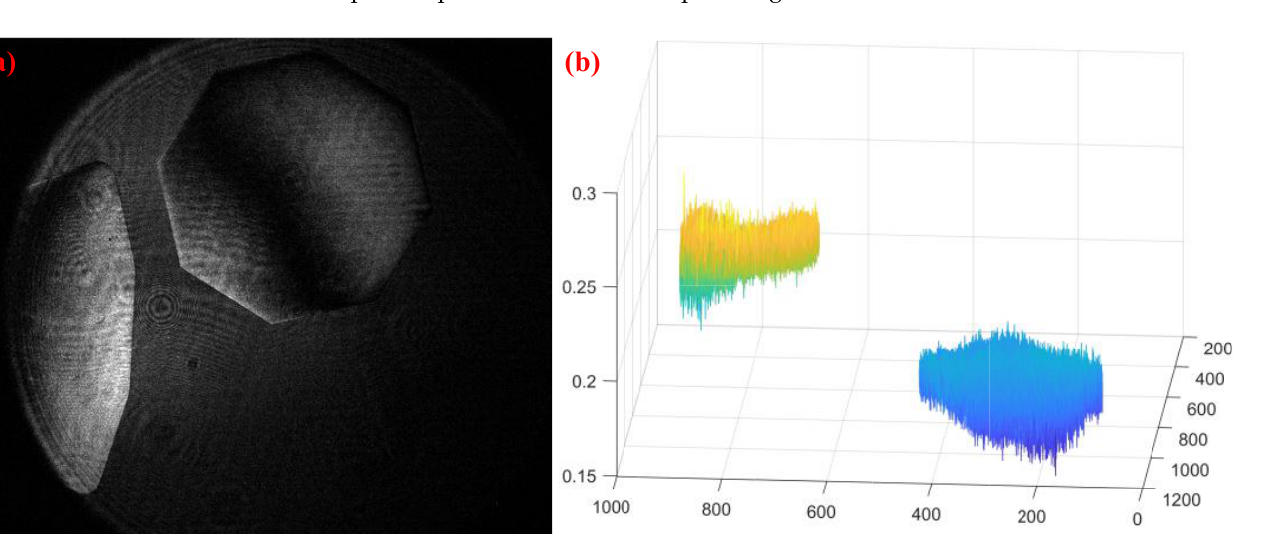
Figure 7. Piston error experimental result. ( a ) Original case; ( b ) 10 μm piston input; ( c ) 20 μm in- put.